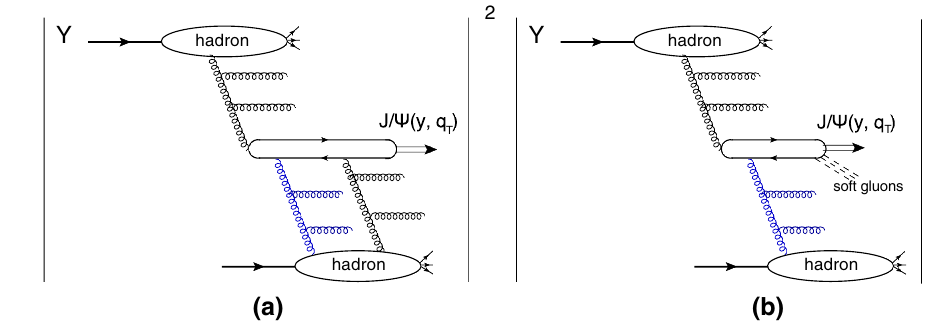
Fig. 1 a Two parton showers contribution to J /ψ